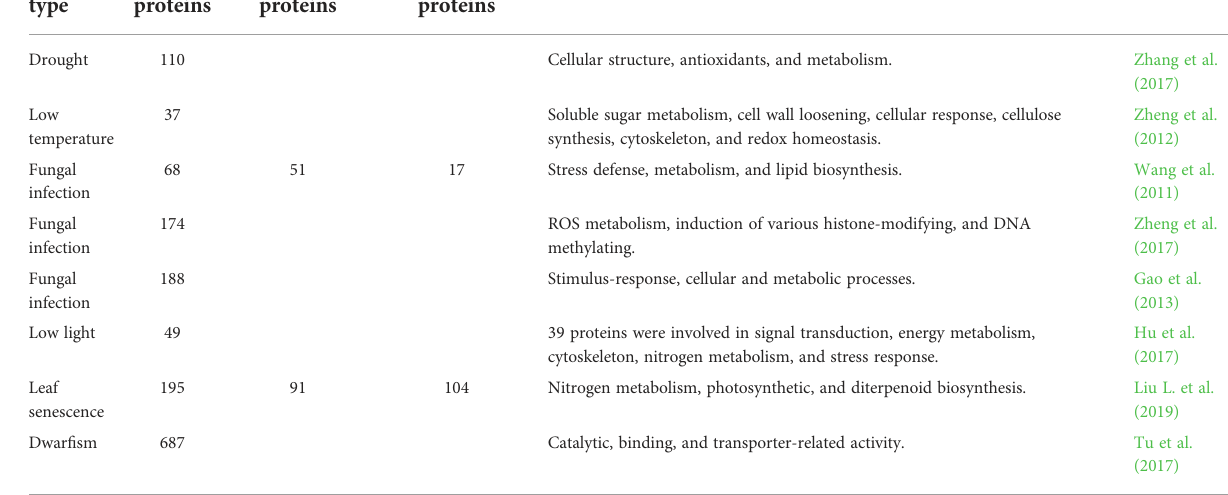
TABLE 2 List of proteins and related